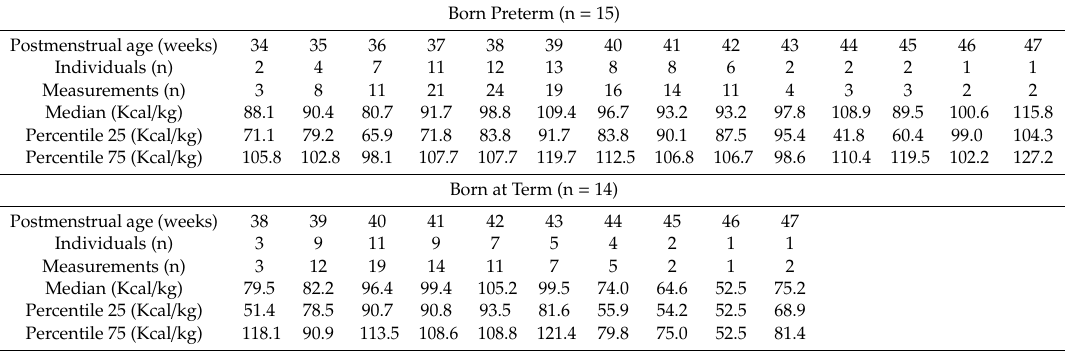
Table 1. Daily energy intake in infants born preterm and at term. Born Preterm (n =